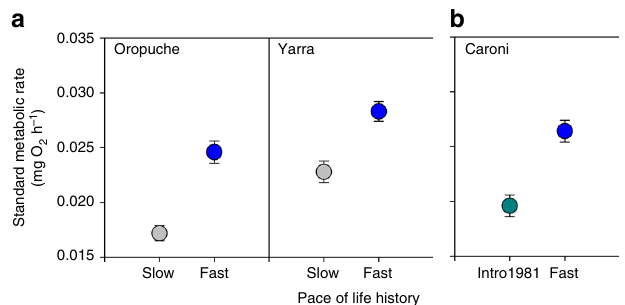
Fig. 1 Metabolic rates differed among populations according to their pace of life history. a Standard metabolic rate (mean ± 1 SE) was lower in naturally occurring populations with a slow (gray) relative to a fast-paced (blue) life history (LMM: P < 0.001) in both the Oropuche (slow: n = 29, fast: n = 28) and Yarra (slow: n = 26, fast: n = 28) River drainages. b Standard metabolic rate (mean ± 1 SE) was also lower in a population transplanted from high- to low-predation sites in 1981 that has since evolved a slow-paced life history (green, n = 22) vs their naturally occurring ancestral population with a fast-paced life history (blue, n = 24) in the Caroni River drainage. Values for standard metabolic rate are standardized to a common body mass of 74 mg (mean across all fi